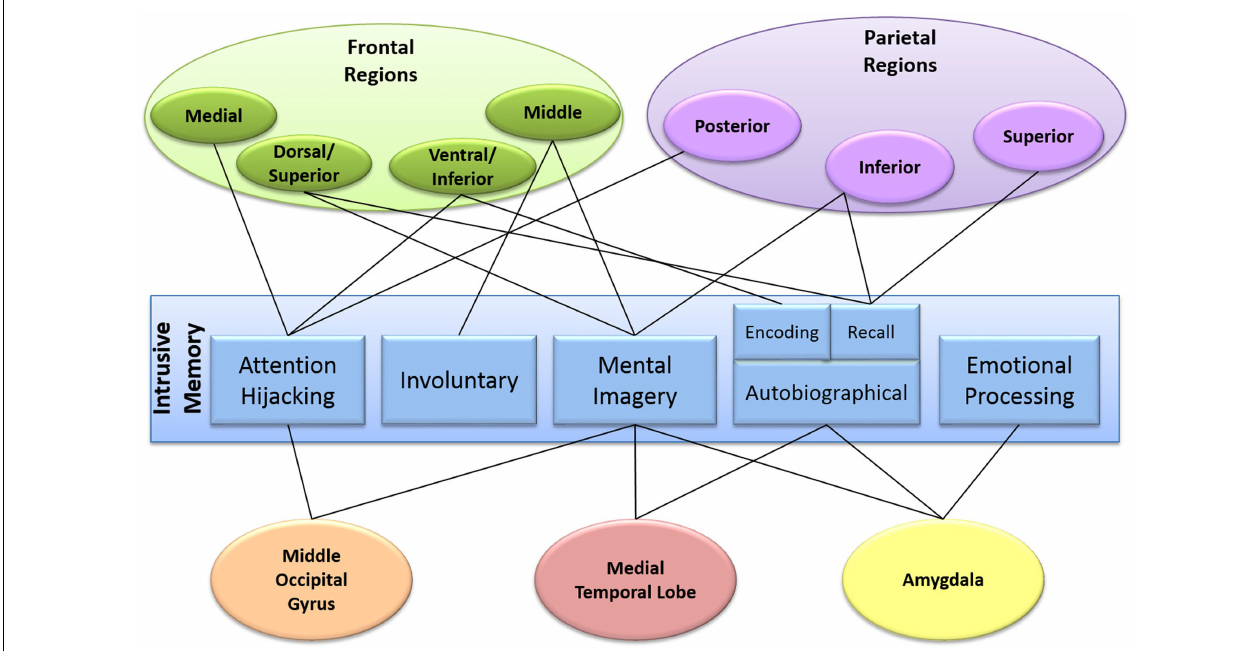
FIGURE 3 | Diagram mapping the patient experience of an intrusive memory onto the brain . The components of our clinical-neuroscience framework are in the center, surrounded by the different brain areas